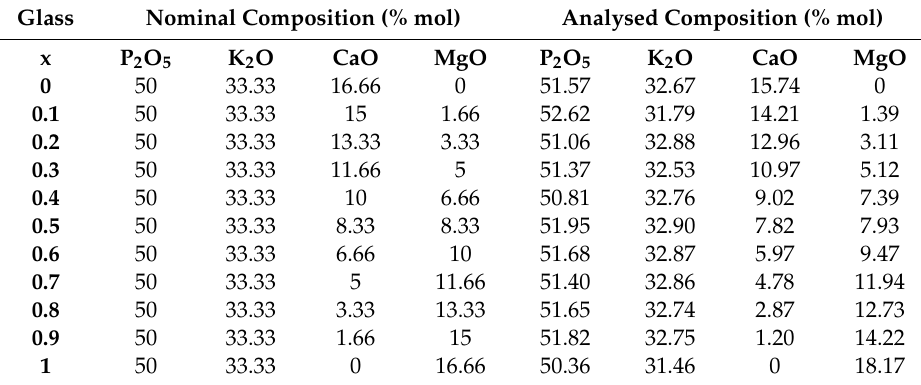
Table 1. Nominal and analysed compositions of the studied